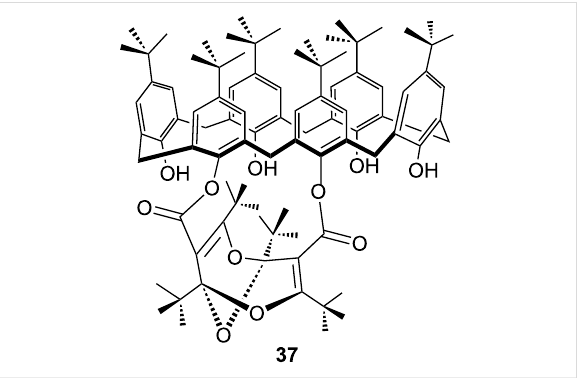
Figure 3: The bisdioxine-calix[6]arene derivative 37 complexes Cs + but does not form a tetraoxaadamantane